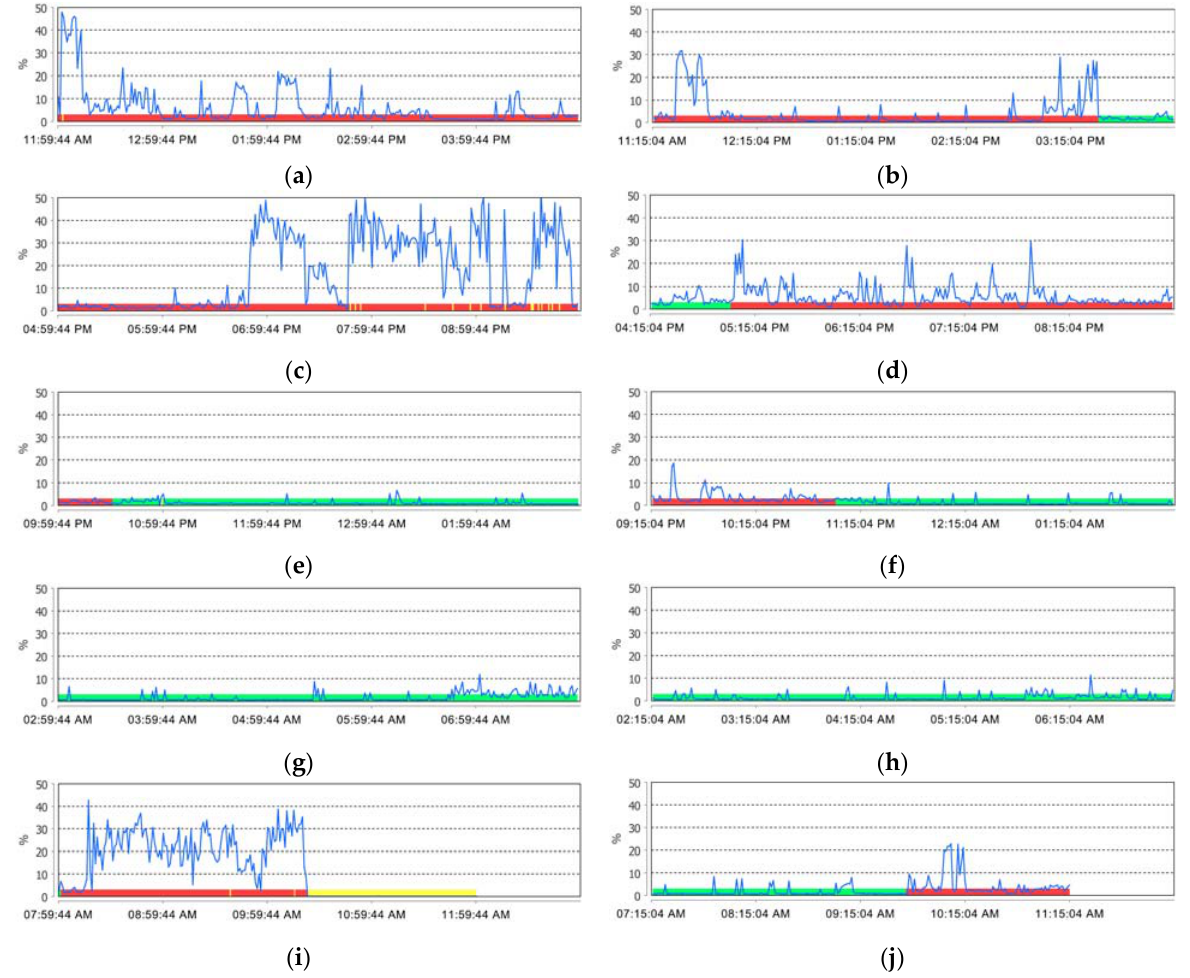
Figure 2. Comparative analysis of the summary of relevant activities recorded at the masseter level (sleep time interval—green color, awake time interval—red color, detachment time interval—yellow color) for: ( a , c , e , g , i ) one participant from the study group and ( b , d , f , h , j ) one participant from the control group.